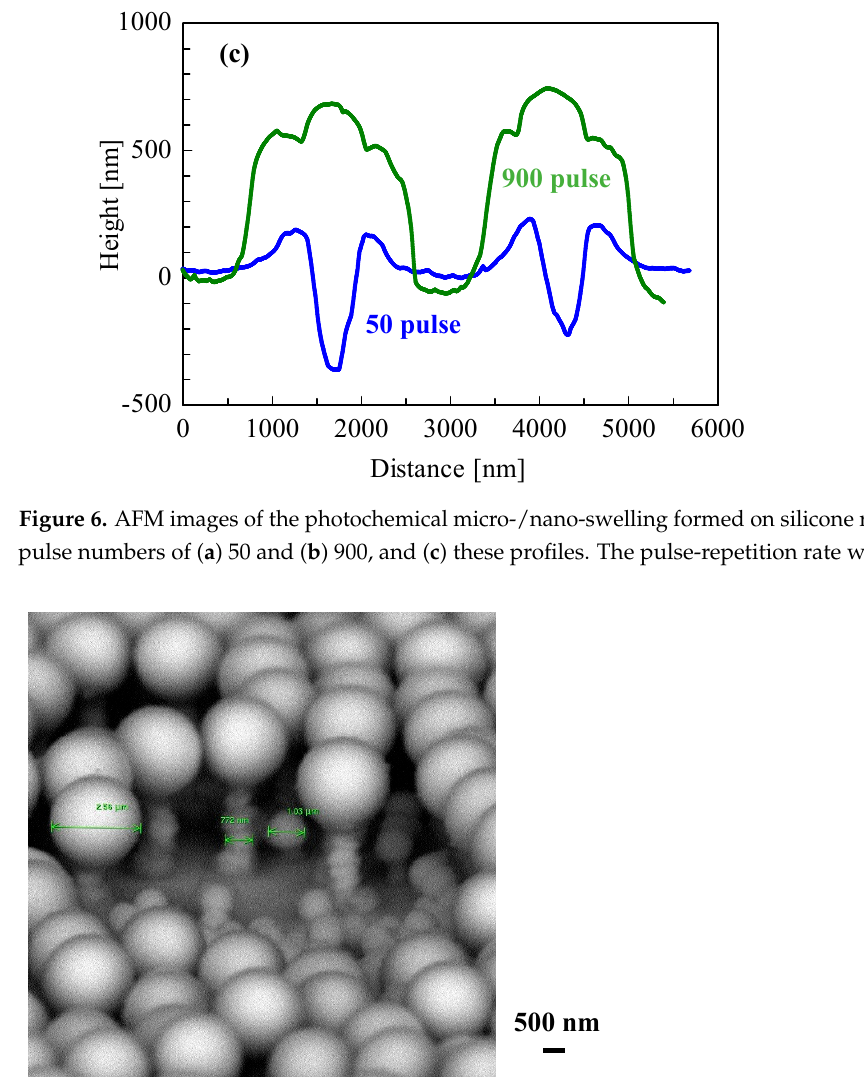
Figure 7. SEM image of the photochemical micro-/nano-swelling underneath silica glass micro- spheres before HF chemical etching when the microspheres were sparsely aligned.